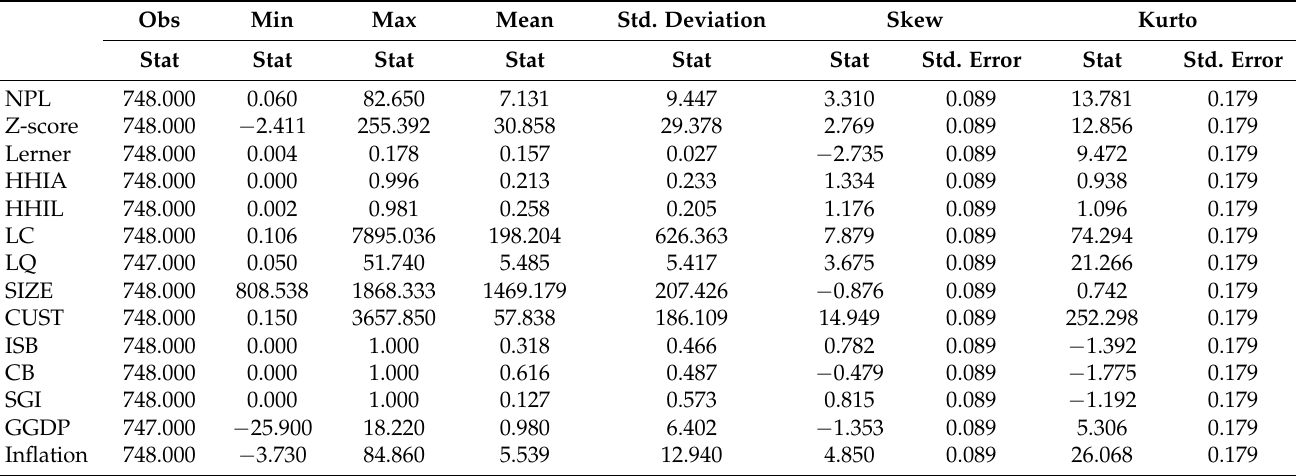
Table 2. Summary of